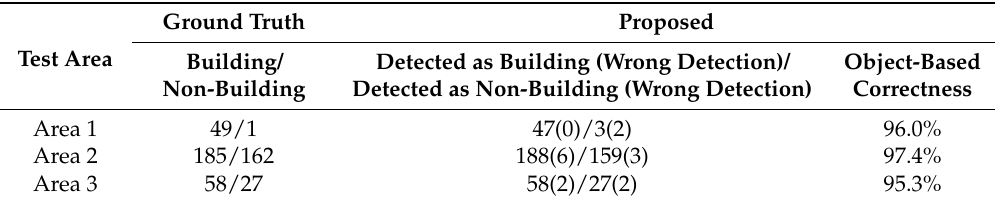
Figure 8. Changed object area extraction by graph cuts, changed object formation by region growing, and object classification with the structural feature. Table 3. Statistics of the object-based classification with the structural